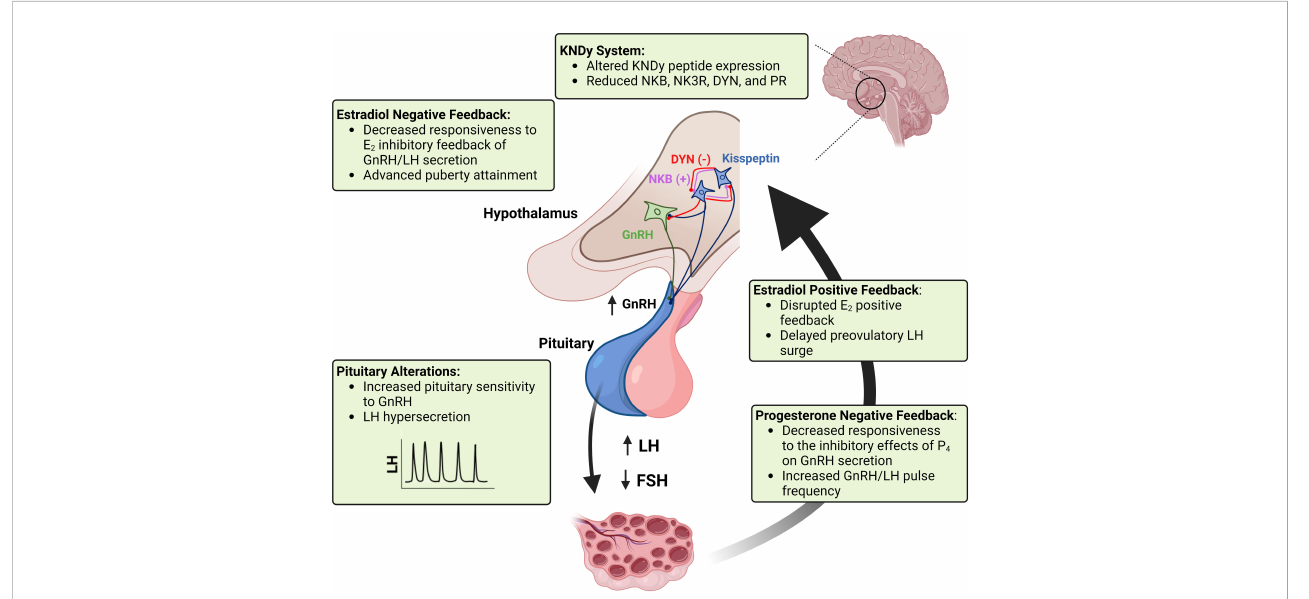
FIGURE 2 A schematic representation of the neuroendocrine alterations seen in the sheep model of PCOS phenotype. Imbalances in KNDy neuron peptide and receptor expression in the hypothalamus disrupt GnRH tonic secretion and responsiveness to steroid hormone feedback systems regulating reproductive cyclicity. Puberty attainment is altered due to decreased responsiveness to the estradiol (E2) inhibitory feedback. Reduced sensitivity to the progesterone (P4) negative feedback and increased pituitary sensitivity to GnRH result in LH hypersecretion and imbalance of the LH : FSH ratio, which in turn impairs follicular development and ovarian steroidogenesis. Impairments in the estradiol positive feedback mechanism result in disrupted (delayed and reduced amplitude) preovulatory surge of LH surge, thus compromising ovulatory capacity. Created with